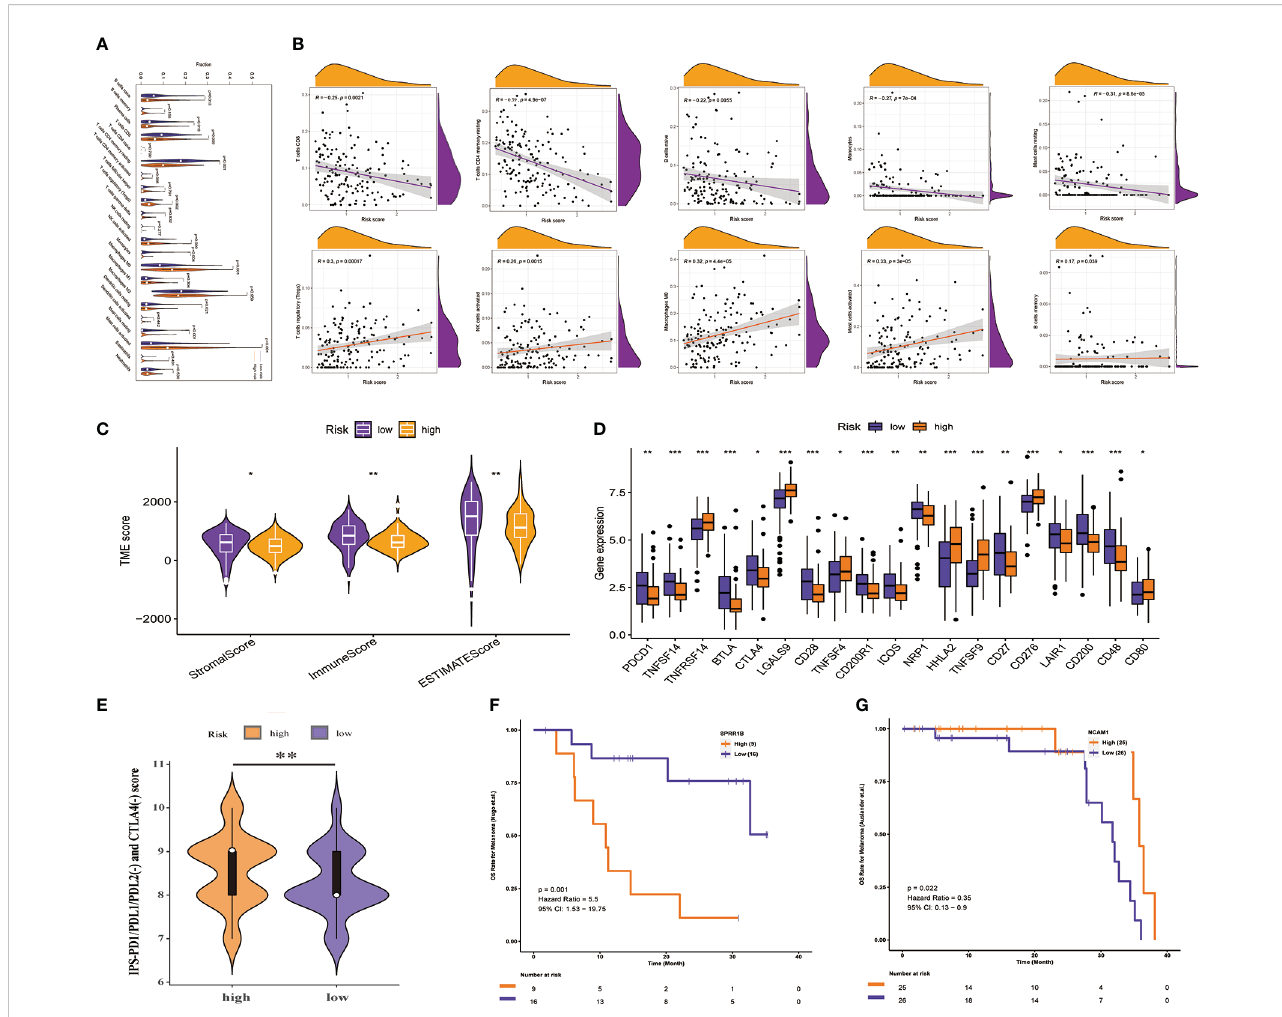
FIGURE 8 Prediction of TIME and immunotherapy response by PMSRPS. (A) Comparison of immune cell in fi ltration in the high- and low-risk groups. (B) Correlation of risk score with in fi ltrating abundance of 10 immune cells. (C) Comparison of tumor microenvironment scores in the high- and low-risk groups. (D) Differential expression of immune checkpoint molecules in the high- and low-risk groups. (E) Comparison of IPS-PD1/PDL1/PDL2(-) and CTLA4(-) scores between the high- and low-risk groups. (F, G) The predictive role of SPRR1B (F) and NCAM1 (G) genes in PMSRPS on existing immunotherapy cohorts was explored via a web server for Comprehensive Analysis on Multi-Omics of Immunotherapy in Pan-cancerimmune checkpoint inhibitors (CAMOIP). * P < 0.05, ** P < 0.01, *** P <